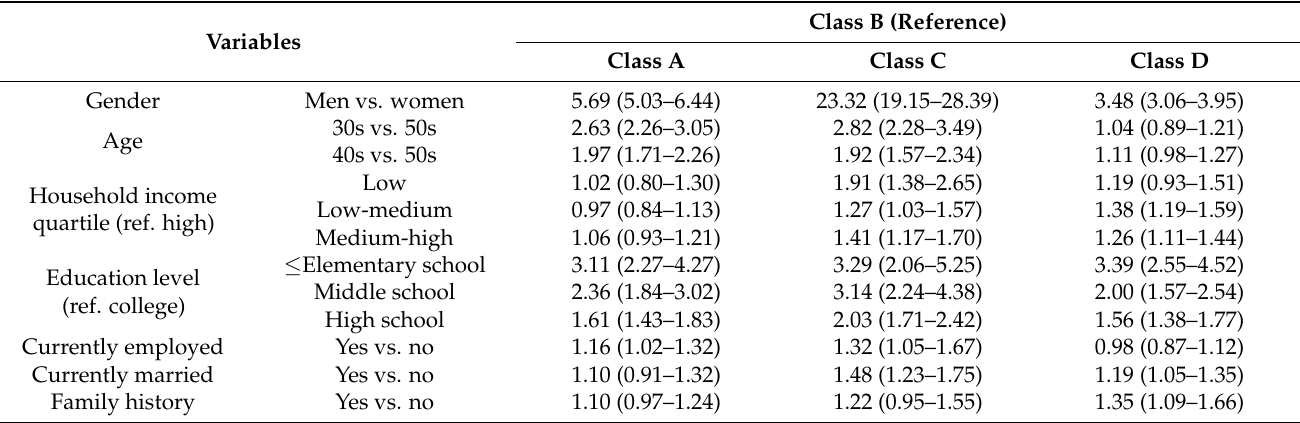
Table 5. Multinomial logistic regression analysis of the latent classes based on the general